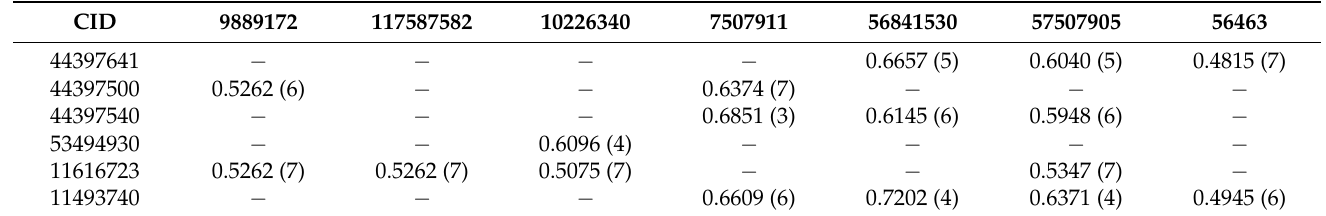
Table 6. The similarity of molecules’ couples, one of them belonging to Benzoylindoles and the other to Phenylacetylindoles (Tanimoto coefficient). The number in the brackets represents the similarity rank. Minus ( − ) signifies that the rank of similarity is higher than eight.